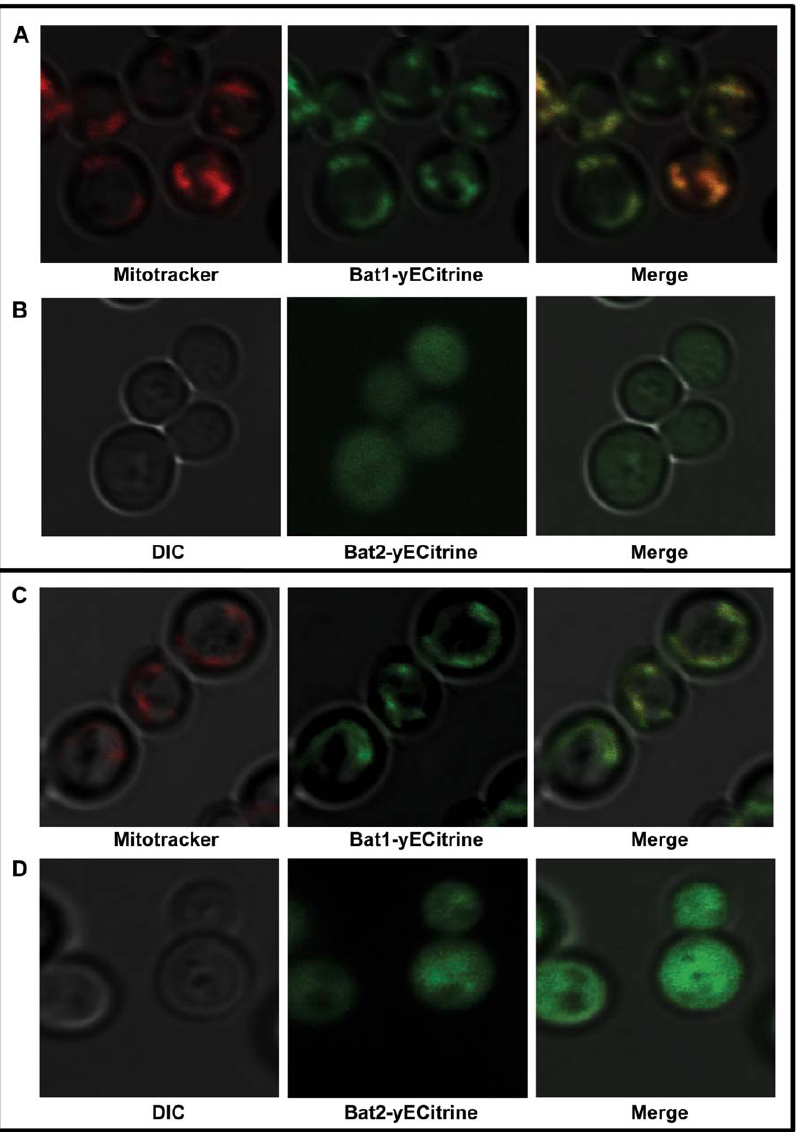
Figure 2. Bat1 is mitochondrially located, while Bat2 is cytoplasmic. Fluorescence images showing the subcellular localization of the paralogous proteins Bat1 and Bat2. Samples were taken from exponentially grown cultures of tagged mutants grown on glucose-ammonium (A, B) or on glucose-VIL (C, D). Mitochondrial localization of Bat1, the signal of the Bat1-yECitrine fusion co-localizes with mitotracker signal (A, C). Cytoplasmic localization of the Bat2-yECitrine fusion (B, D).